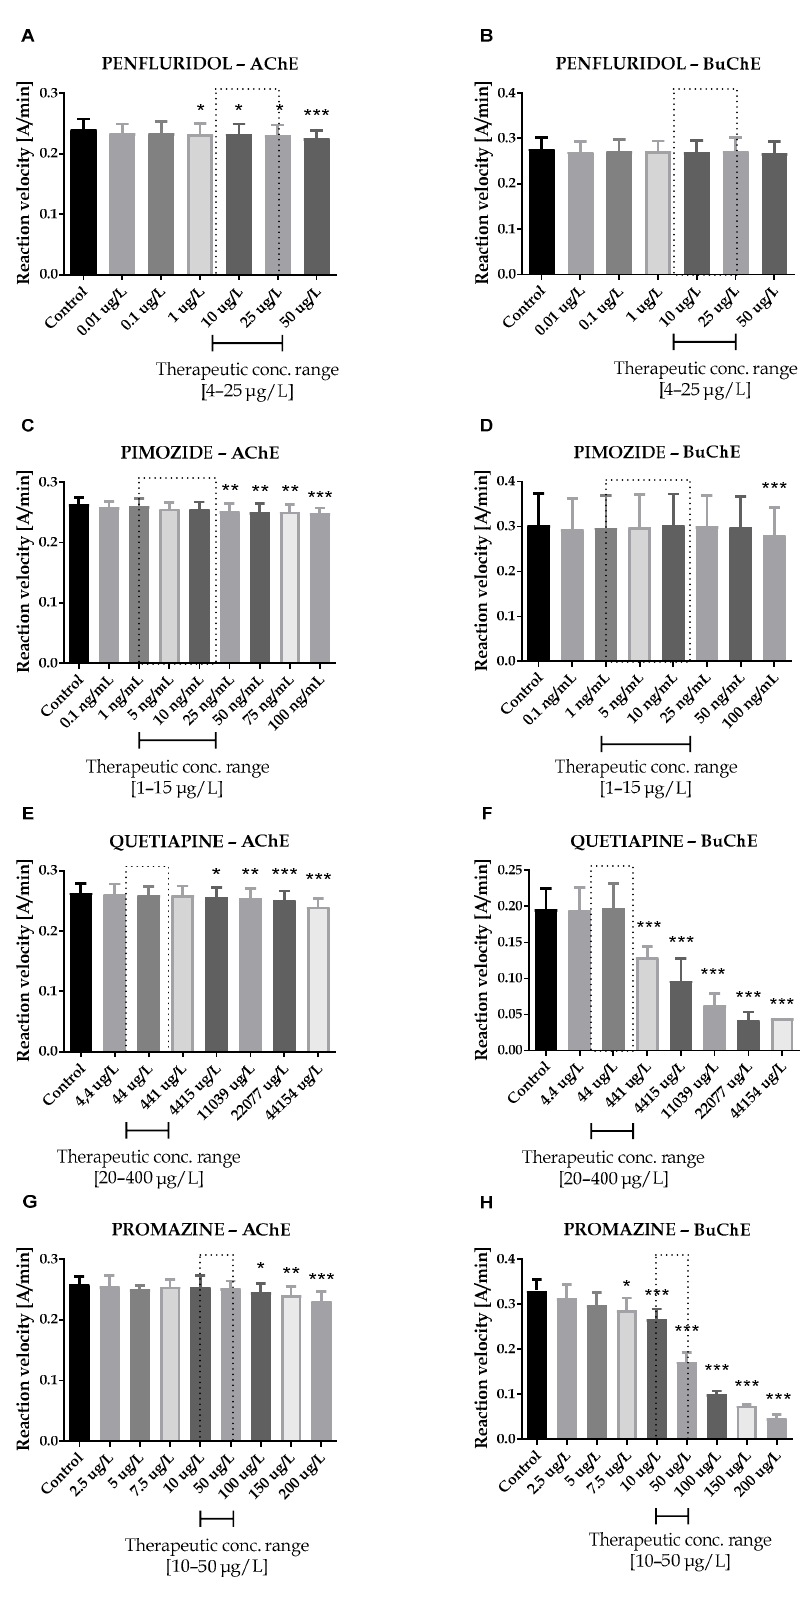
Figure 2. Effects of penfluridol ( A , B ), pimozide ( C , D ), quetiapine ( E , F ) and promazine ( G , H ) on AChE and BuChE in vitro activity, respectively. Each data point represents mean ± SD for at least three independent experiments conducted in duplicates. * p < 0.05, ** p < 0.01, *** p < 0.001 vs. control.